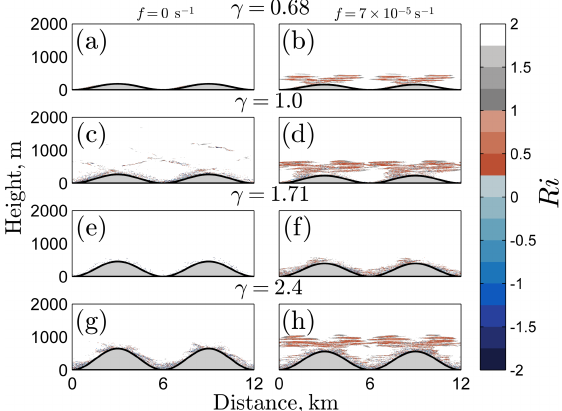
Figure 7. Instantaneous Richardson number, calculated at t = 39.9 tidal periods for f = 0 ( left ) and f = 7 × 10 − 5 s − 1 ( right ), for four different values of γ : (a, b) γ = 0.68, (c, d) γ = 1.0, (e, f) γ = 1.71, (g, h) γ = 2.4, all at λ x = 6 km.